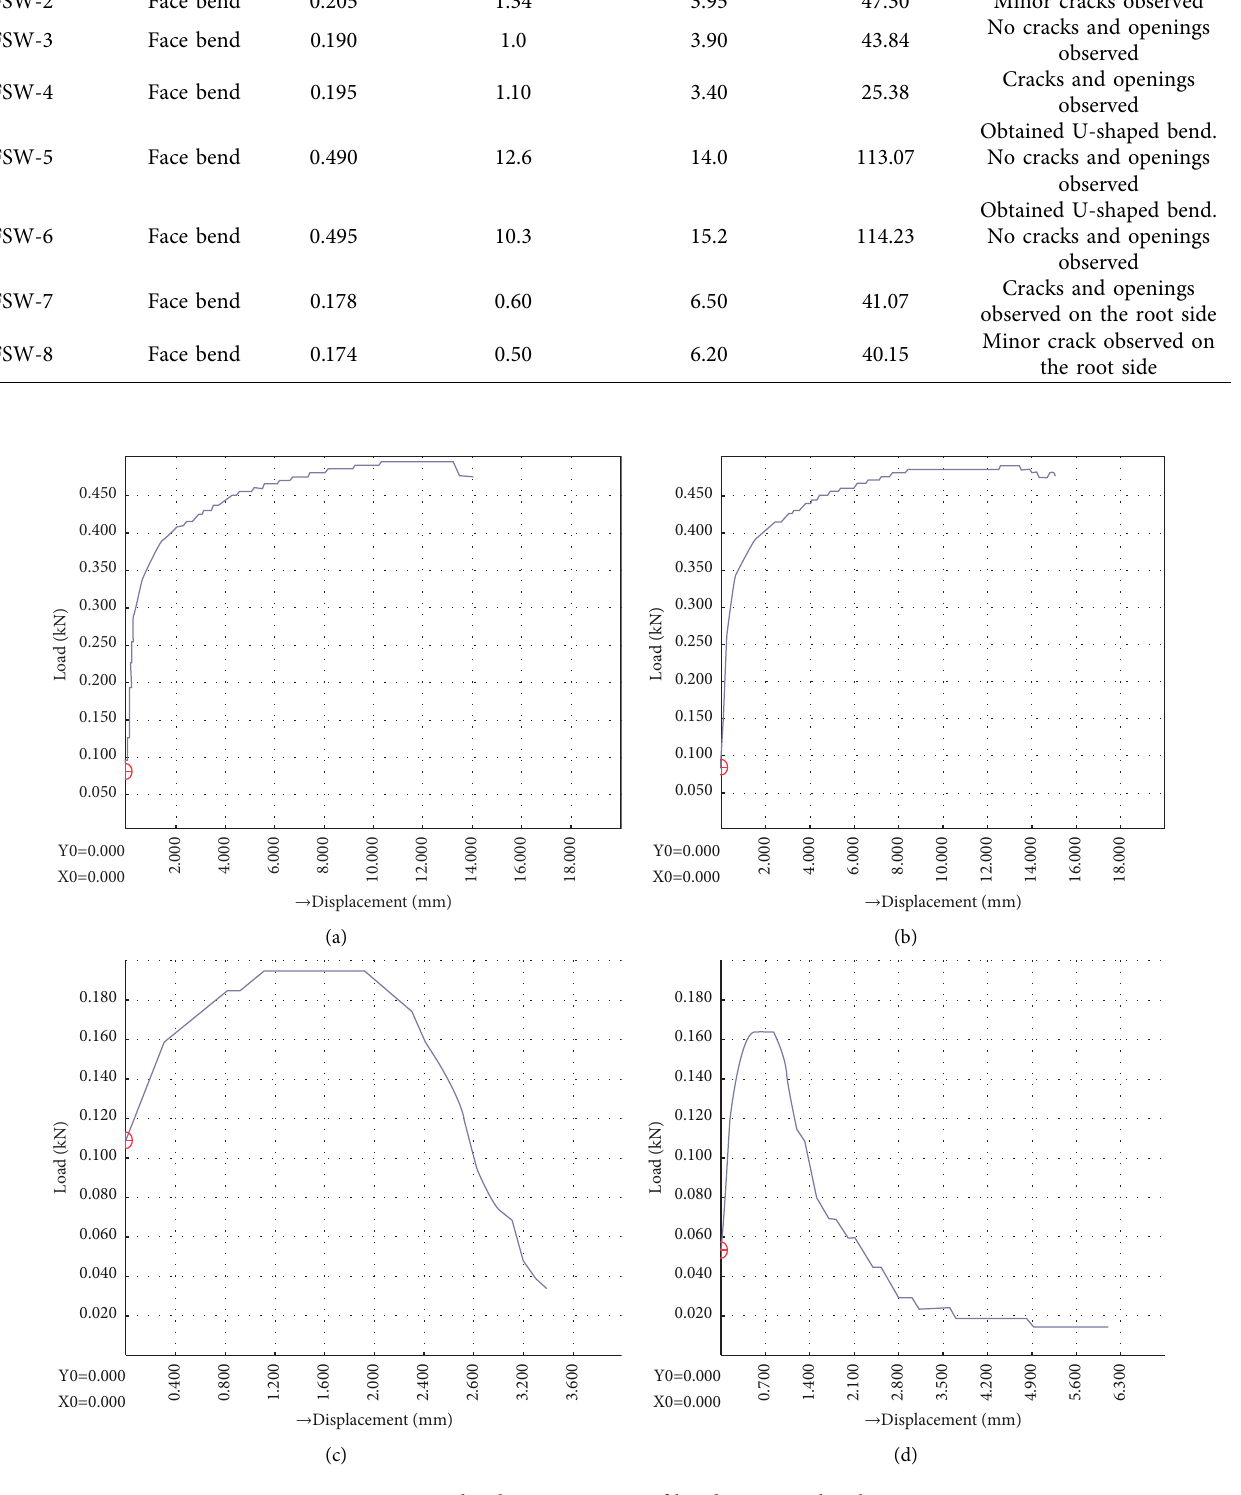
Figure 8: Graphical representation of bending strength values.